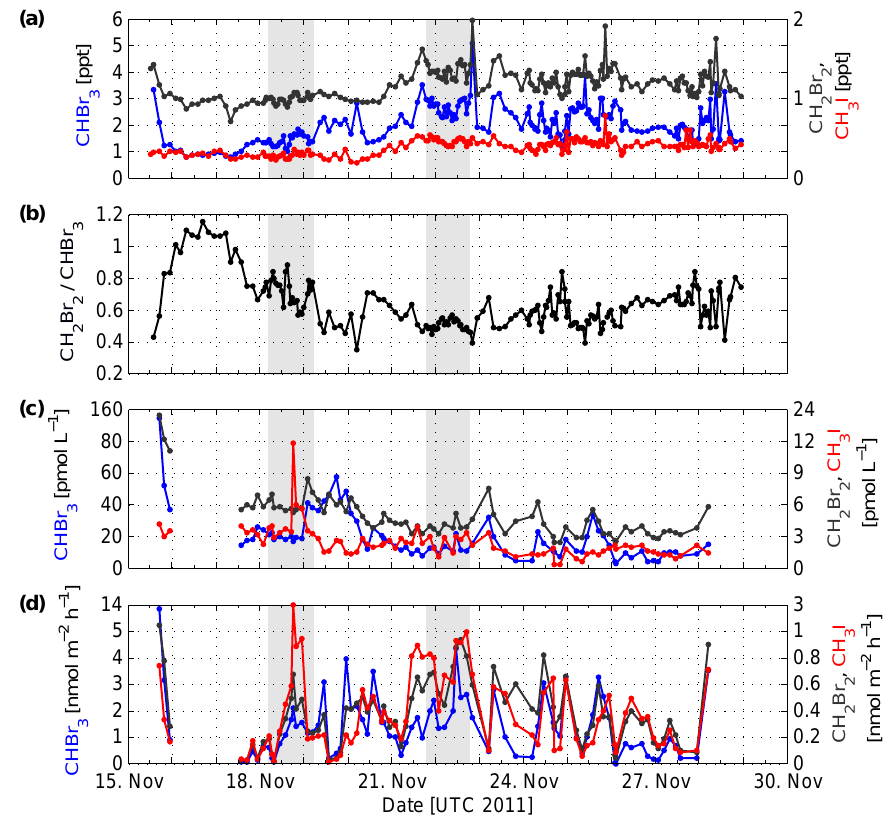
Figure 4. R/V Sonne measurements of (a) atmospheric mixing ratios of CHBr 3 (blue), CH 2 Br 2 (dark grey) and CH 3 I (red); (b) concentration ratio of atmospheric CH 2 Br 2 and CHBr 3 ; (c) water concentrations of CH 3 I, CHBr 3 and CH 2 Br 2 ; and (d) calculated emissions of CHBr 3 , CH 2 Br 2 and CH 3 I from atmospheric and water samples. The two shaded areas (light grey) in the background show the 24h stations. y axis for (c) and (d) are